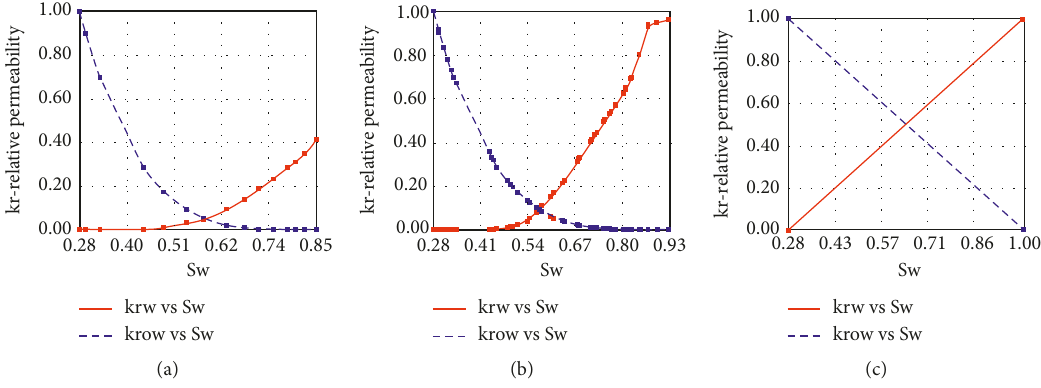
Figure 24: Relative permeability curves used in the simulator.